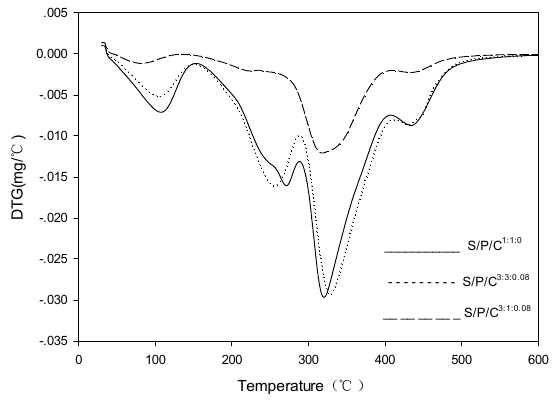
Figure 4. DTG thermograms of starch/polyvinyl alcohol/citric acid ternary blend functional food packaging films.